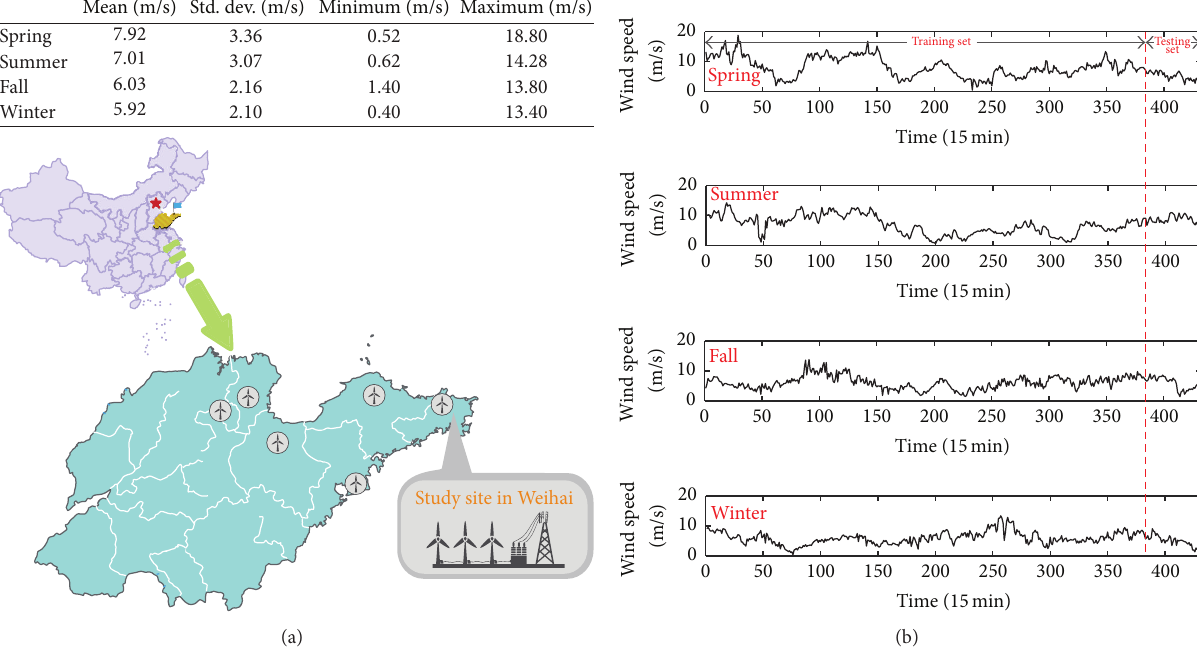
Figure 5: Specific location of the study sites and the statistical measures of original wind speed datasets in Weihai.